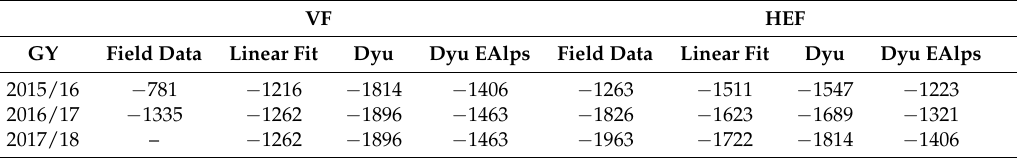
Figure 8. Mass balance (B) versus accumulation area ratio (AAR) distribution for 53 years of records for Vernagtferner (VF) ( a ) and 66 years of records for Hintereisferner ( b ) (HEF). Black circles indicate results from the linear approximation by Dyurgerov et al. [37]. Correlation coefficients and formulation for the linear fit are presented. Table 5. Annual mass balance (B) estimates from field data and annual minimum accumulation area ratios (AAR) determined from Sentinel-1 (S1) scenes. For conversion from accumulation area ratio (AAR) to B, we used the formulations of the linear fit for Vernagtferner (VF) and Hintereisferner (HEF) displayed in Figure 8, Dyurgerov’s average relationship [37] (Dyu) for all glaciers and specified just for the Eastern Alps (Dyu EAlps). All mass balance values are presented in millimeter water equivalent (mm